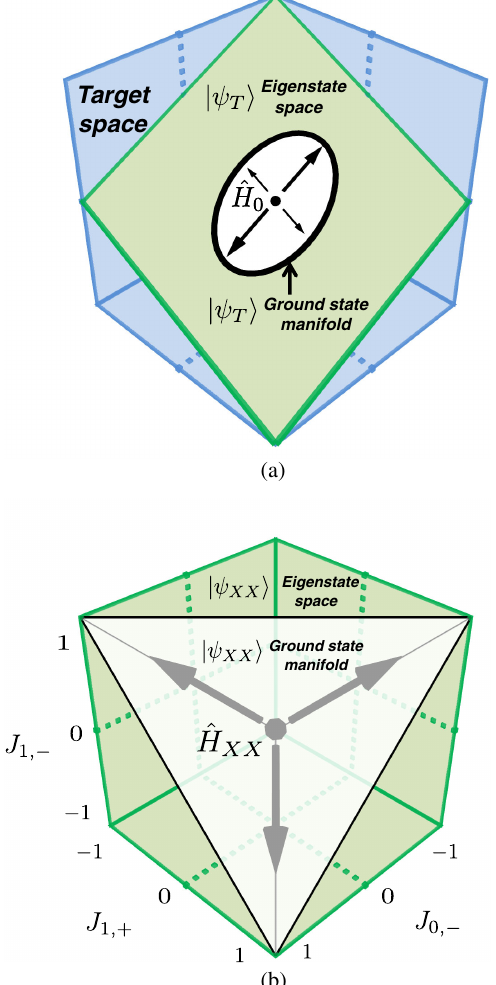
FIG. 6. Phase expansion schematic and example. (a) Schematic representing the expansion of a phase diagram about a known ˆ H ψ Hamiltonian 0 , which has a known ground state j T i . Shown is the target space (blue) provided as input to the EHC method, the eigenstate space (green) of j ψ T i produced as the output of EHC and the expanded ground-state manifold (white) of j ψ T i . (b) Numerical ˆ H results for the phase expansion about the Hamiltonian XX with groundstate j ψ XX i .Shownisathree-dimensionalprojection(green) of the six-dimensional eigenstate space of j ψ XX i , given by Eq. (11) with J 0 ; ¼ 1 and J 2 ; ¼ 0 and the ground-state manifold of j ψ XX i þ (cid:2) (white), which almost has the shape of a tetrahedron. For simplicity of visualization, here, we plot a tetrahedron, which contains most of the ground-state manifold, though it ignores a small curved region that extends slightly beyond the